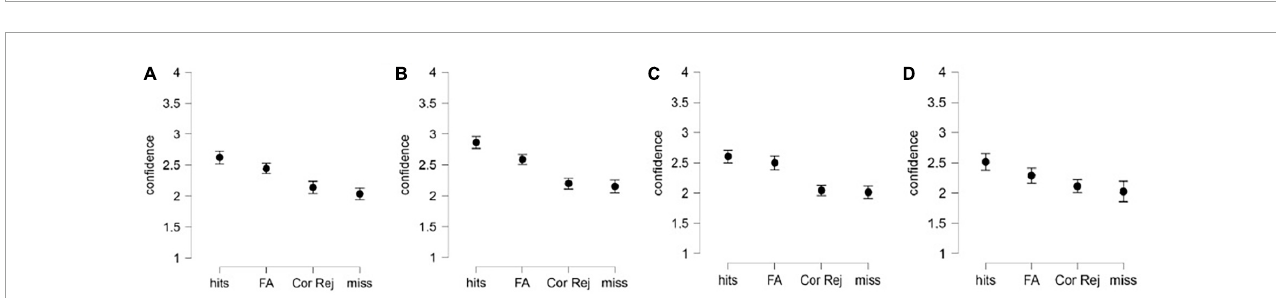
FIGURE3 Confidence ratings assigned to correctly endorsed constituents (hits, “yes” responses), incorrectly endorsed foils (false alarms, “yes” responses), correctly rejected foils (correct rejections, “no” responses), and incorrectly rejected constituents (misses, “no” responses). Confidence ratings are represented separately for auditory (A) linguistic material, (B) non-linguistic material and visual, (C) linguistic material, and (D) non-linguistic material modalities. Error bars stand for 95%CI.